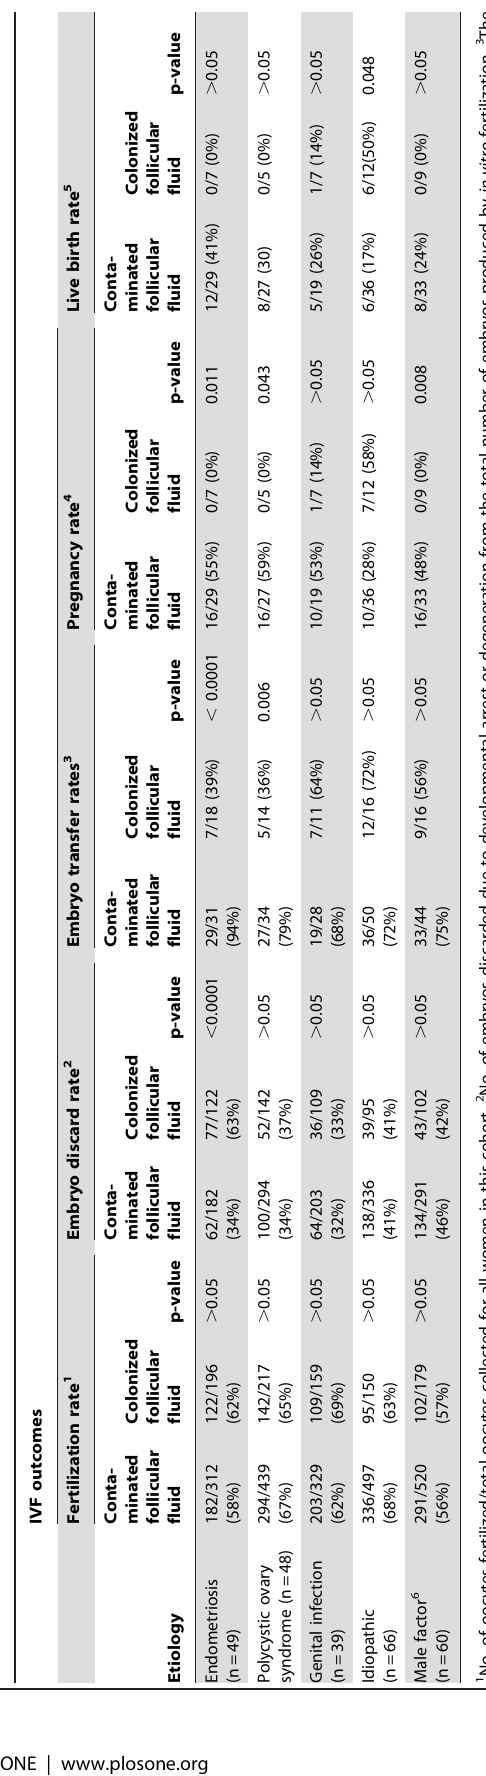
alone or in combination with microaerophiles or anaerobes when a positive IVF outcome was achieved. In contrast, there is an absence of lactobacilli when poor IVF outcomes were reported. As the map is viewed from top (positive IVF outcomes) to bottom (negative IVF outcomes) there is a transition from green through to red, demonstrating the particularly negative impact of isolating anaerobes in the absence of Lactobacillus spp. Statistical analyses on all individual species were not appropriate due to the small number of observations reported for some; however, the heat map does correlate with findings reported for species with sufficient observations, and provides additional information pertaining to the remaining species isolated from the genital tract specimens of women undergoing IVF cycles.